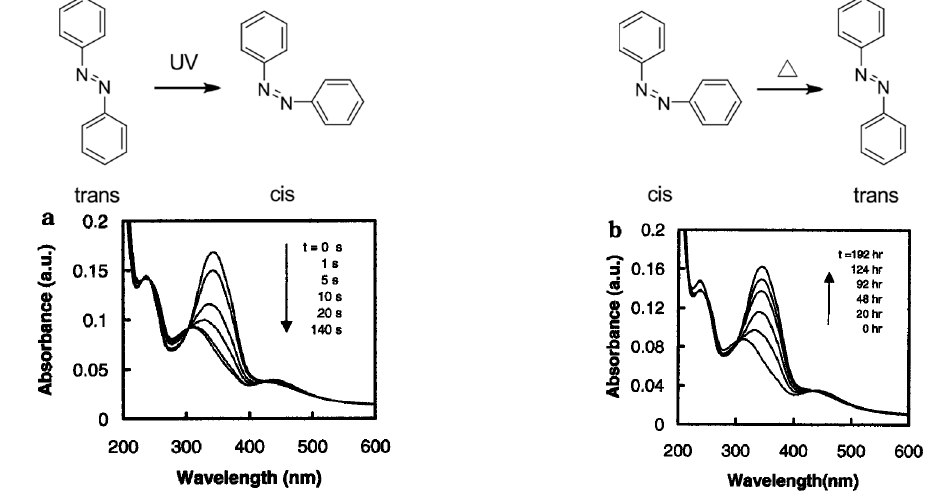
Figure 2. Typical UV–visible absorption spectra of an azobenzene-containing LbL film for trans-to-cis isomerization under UV light ( a ) and those of thermal cis-to-trans isomerization in the dark ( b ). Reprinted with permission from Ref. [50]. Copyright 2001 American Chemical Society.